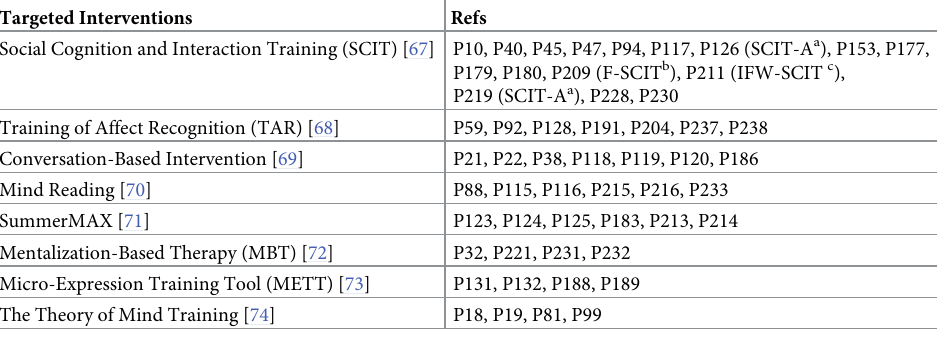
Table 4. Targeted interventions in social cognitive remediation. Targeted